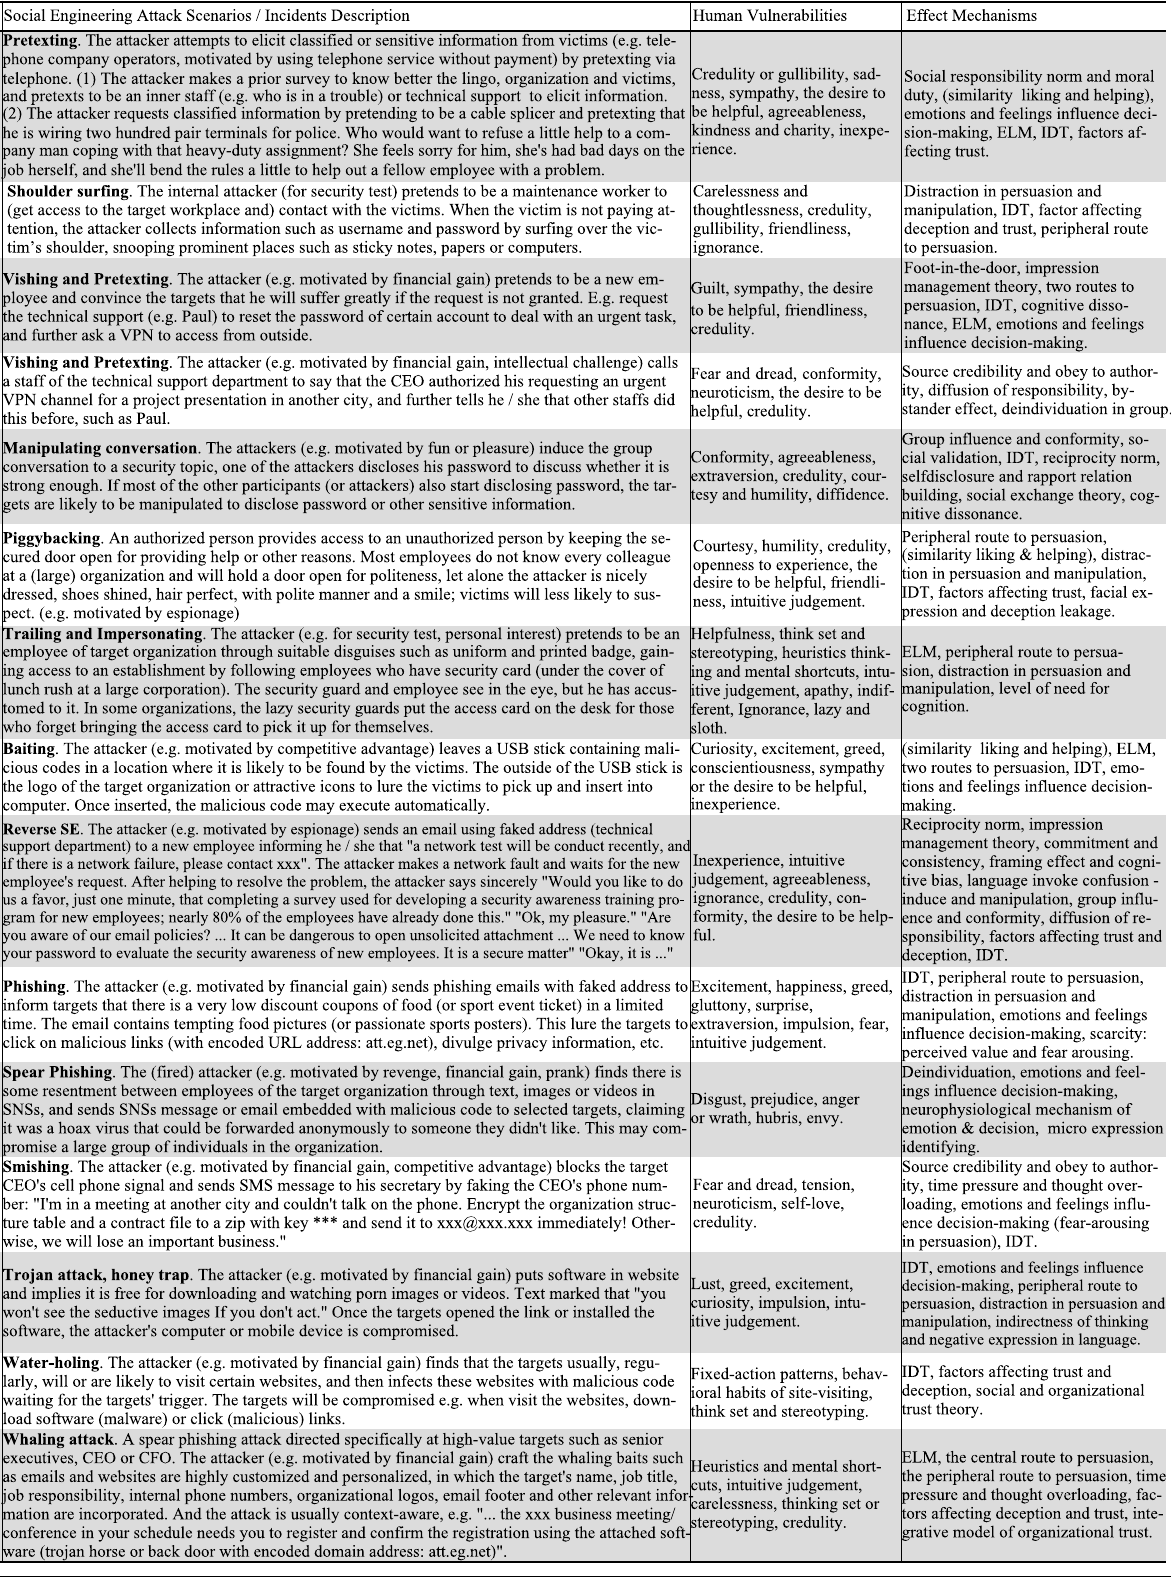
Table 5 Material of social engineering attack scenarios / incidents adopted from (Wang et al. 2020; Wang et al. 2021) and used to generate knowledge